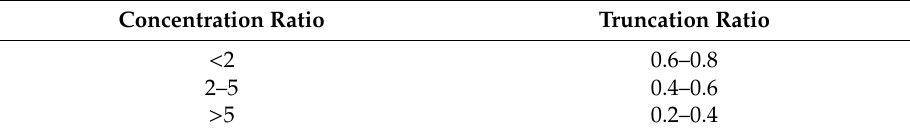
Table 3. Recommended truncation